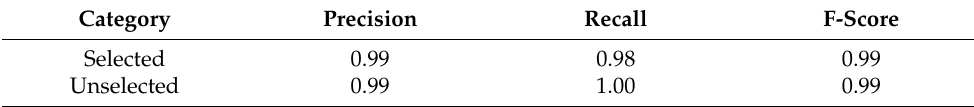
Table 3. The classification results of finding the selected entry in the project window. Category Precision Recall F-Score Selected